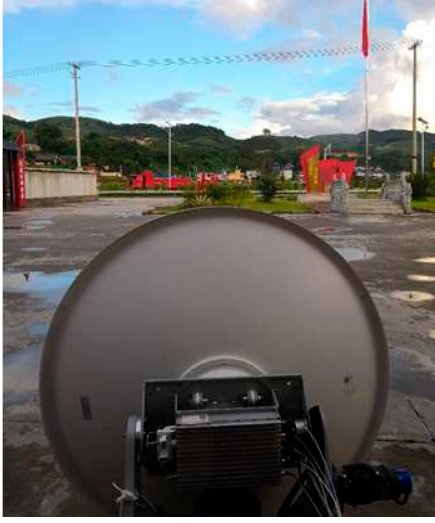
Figure 10. Ku-band entomological radar